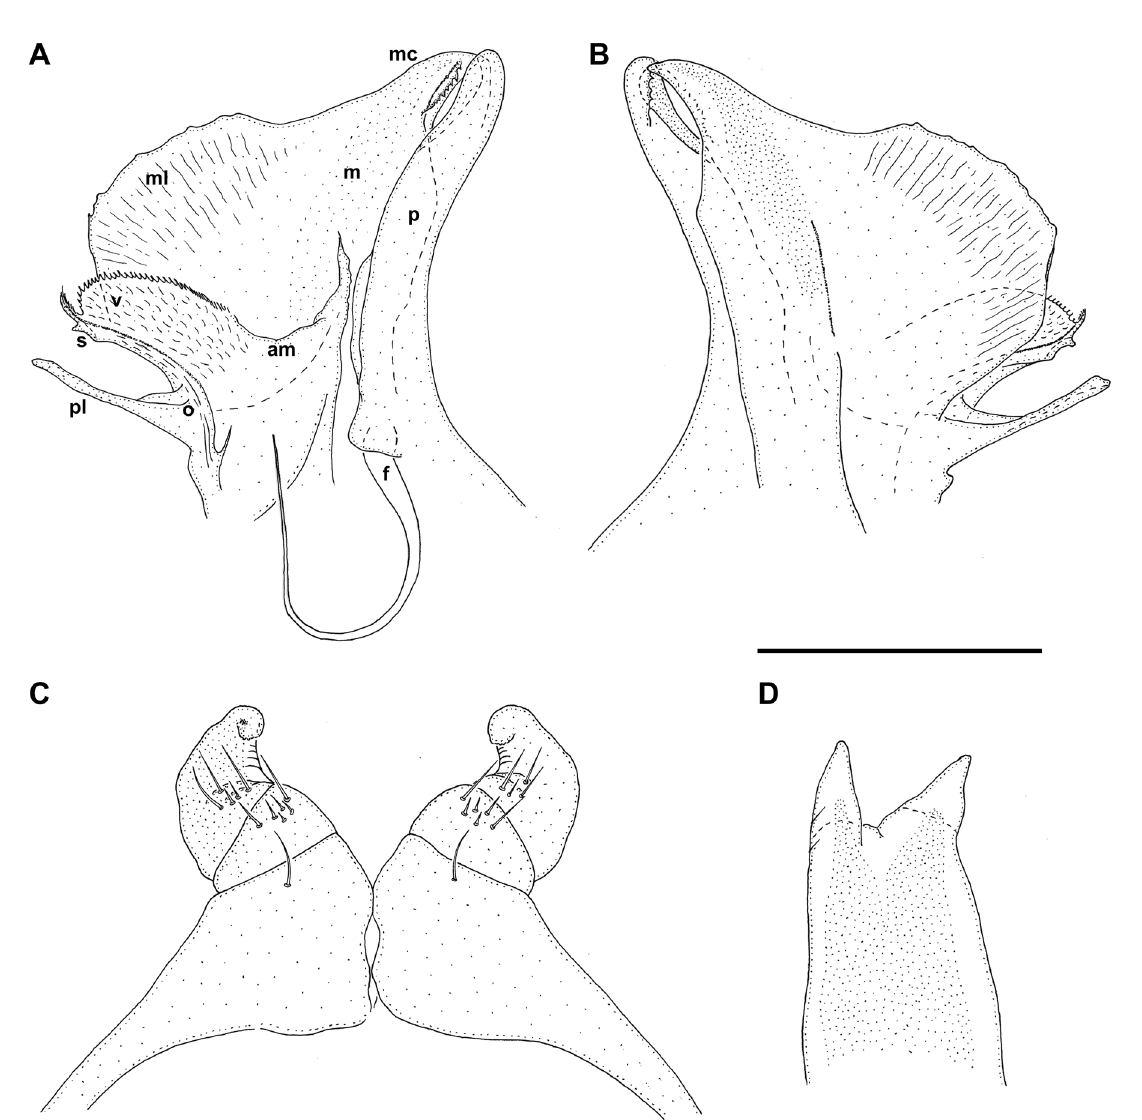
Fig. 49. Leucogeorgia turbanovi sp. nov., paratype ♂ from Pechalnaya Cave (ZMUM). A . Right gonopods, lateral view. B . Right gonopods, lateral view. C . Leg-pair 1, anterior view. D . Penes, posterior view. Abbreviations: am = accessory membrane; f = flagellum; m = mesomere; mc = mesomeral claw; ml = mesomeral lamella; o = opisthomere; p = promere; pl = protective lamella; s = solenomere; v = velum. Scale bar: 0.3